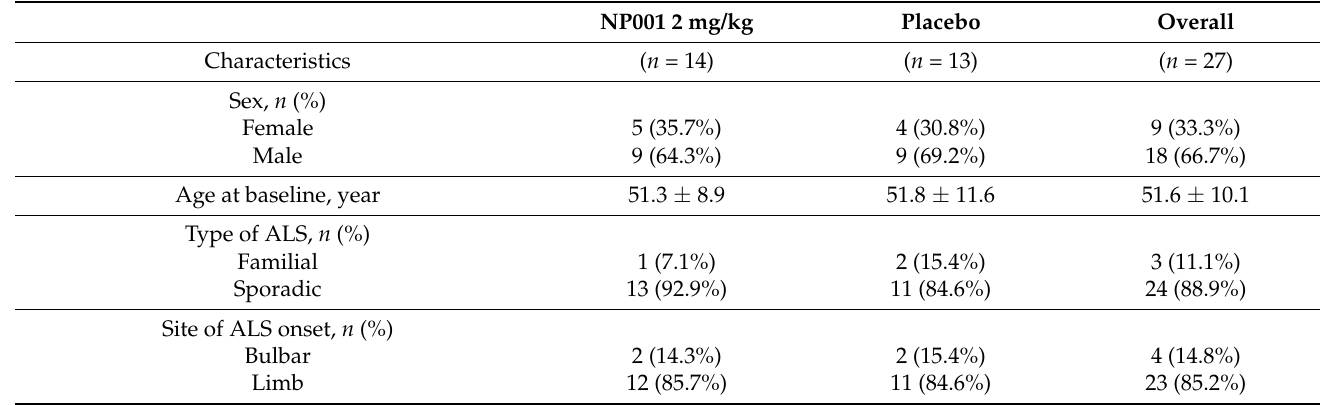
Table 2. Baseline demographics and characteristics of patients ≤ 65 years old and plasma CRP < 1.13 mg/L for those who completed the phase 2A